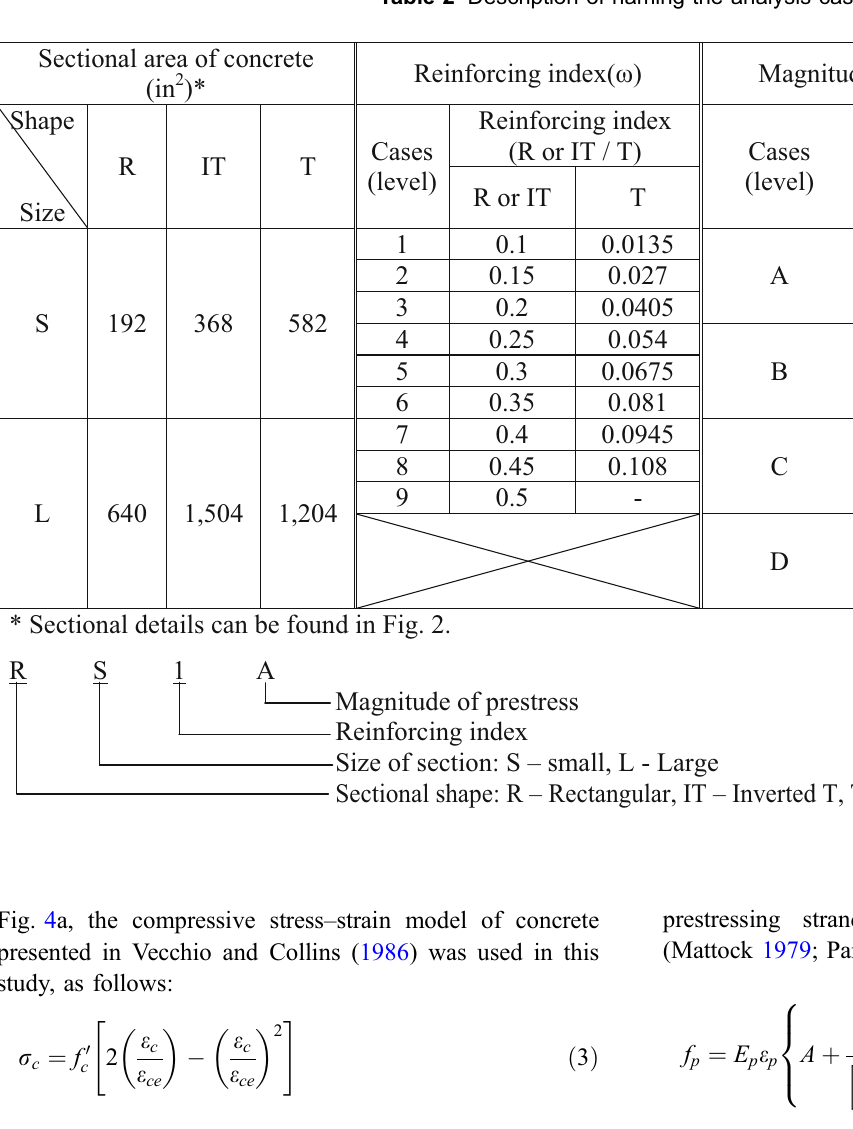
Table 2 Description of naming the analysis cases.